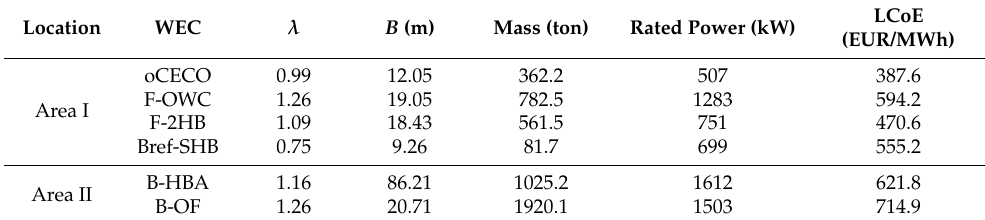
Table 4. Techno-economic optimisation of case-study WECs.